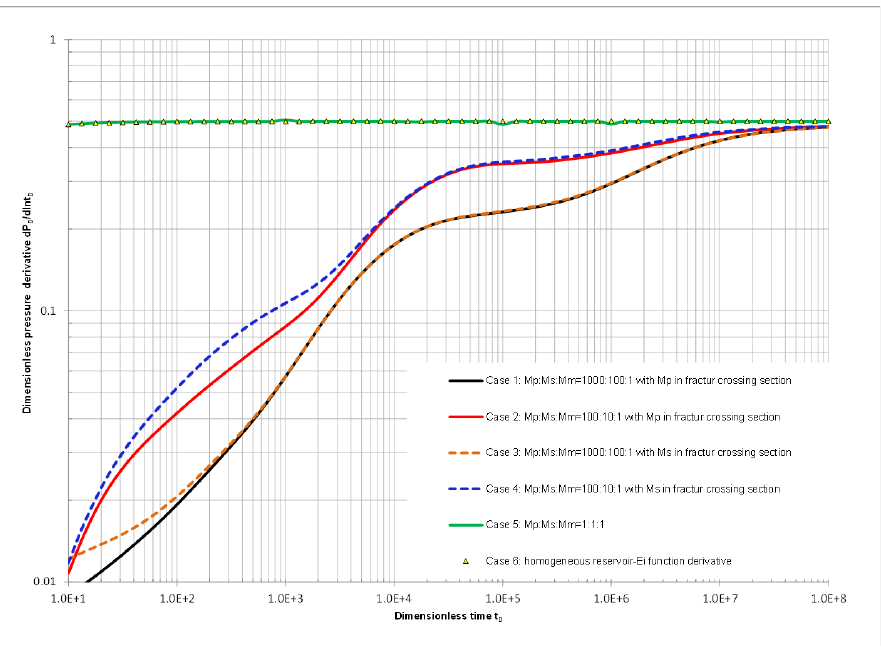
Figure 26. dP D /d(lnt D ) responses for the six cases based on the simplified fracture network model.